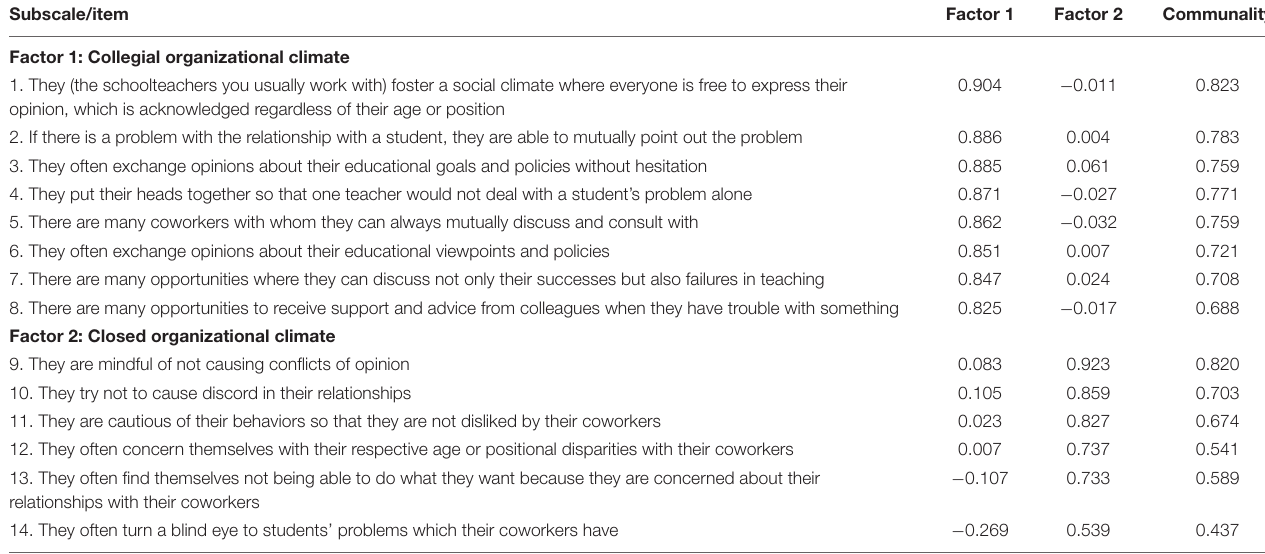
TABLE 1 | Factor loadings of the subscales of the teachers’ perceptions of organizational climate scale.